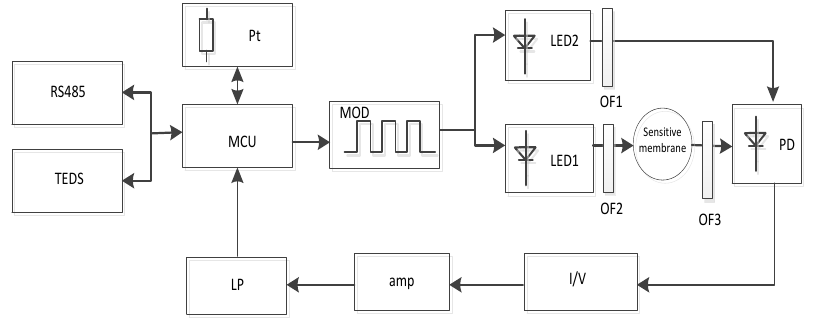
Figure 3. Schematic of the signal conditioning module.